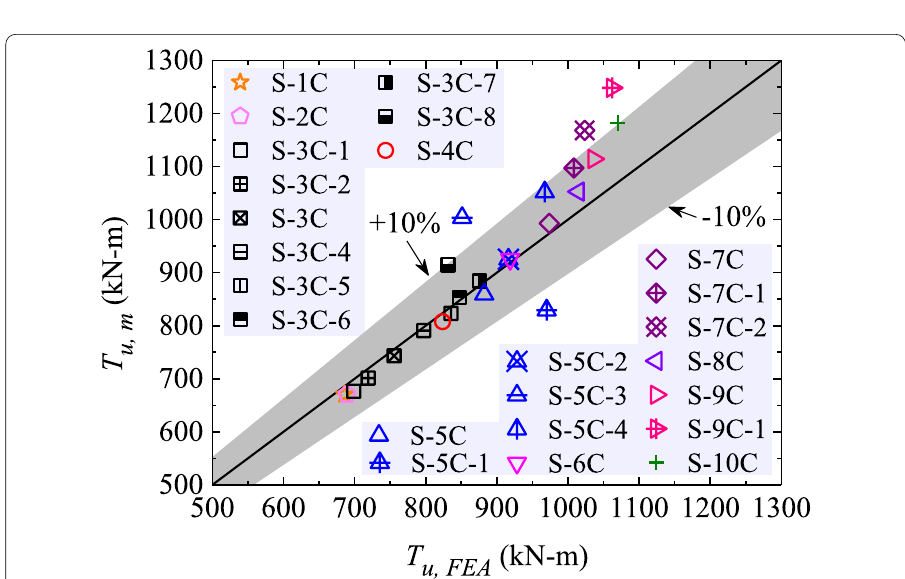
Fig. 8 Comparisons of the ultimate torques between the FEA results and the calculated results from the